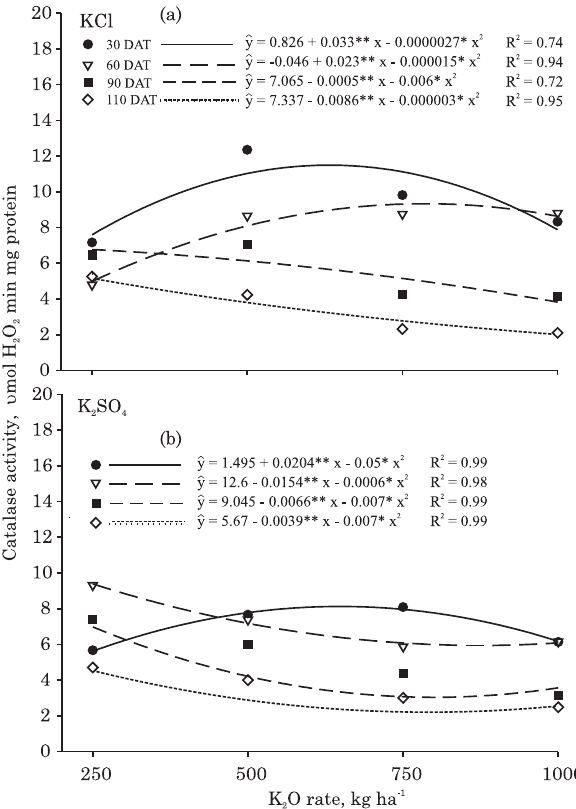
Figure 2. Effect of K sources and rates on catalase activity in eggplant leaves at 30, 60, 90, and 110 days after transplanting